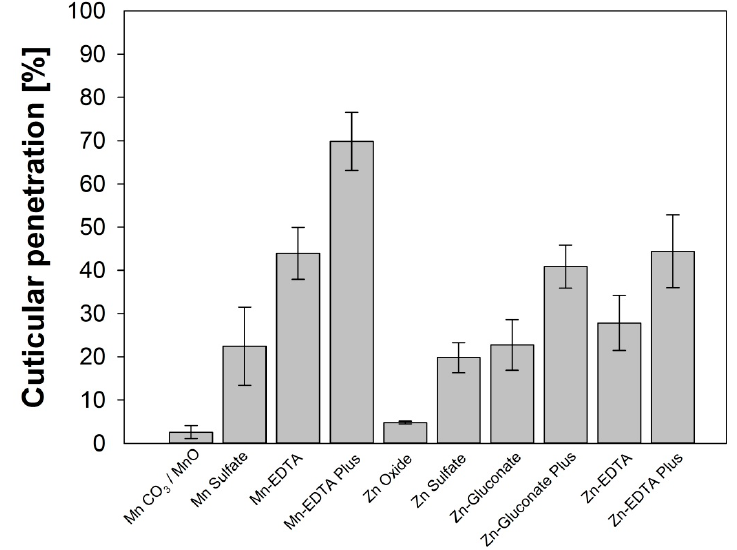
Figure 4. Cuticular penetration (%) of the selected compounds. Means ± standard deviation ( n = 8).